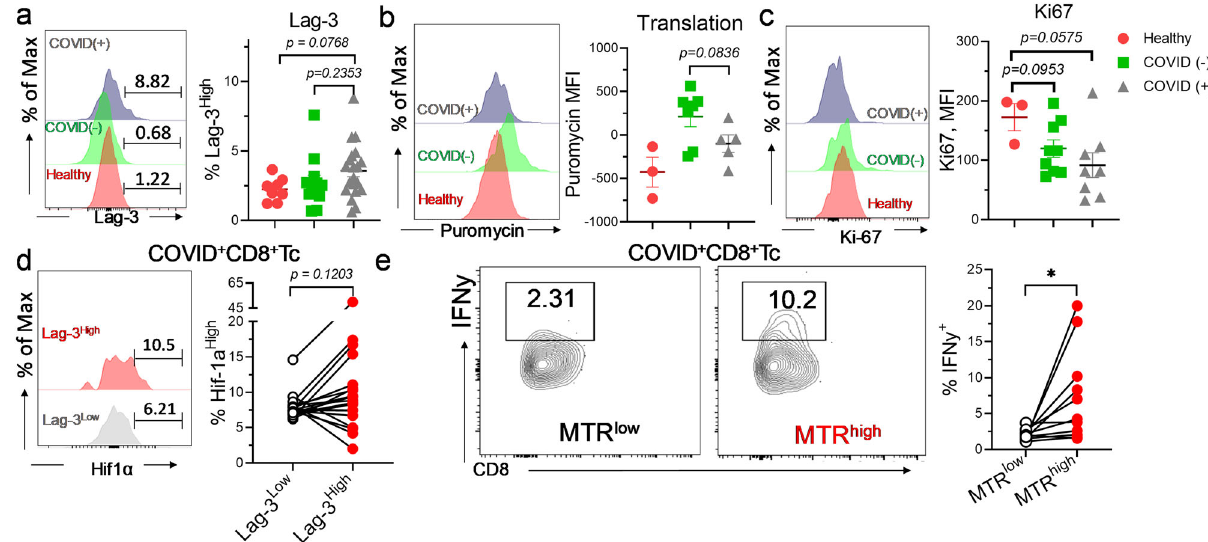
Fig. 3 CD8 + Tc are functionally exhausted in severe COVID-19 patients. Freshly isolated PBMCs were evaluated for metabolic properties by fl ow cytometry. a – c Representative histogram and summary graph demonstrating the abundance of lag-3 + CD8 + Tc ( n = 8 HD, 12 C − , 20 C + ) ( a ), cellular translational level via Puromycin ( n = 3 HD, 7 C − , 5 C + ) ( b ), and Ki-67 expression ( n = 3 HD, 9 C − , 8 C + ) ( c ) in CD8 + Tc from healthy, COVID( − ), and COVID( + ) patients. d Representative histogram and paired graph abundance of HIF-1 α High cells in lag-3 low and lag-3 high CD8 + Tc from COVID( + ) patients ( n = 18). e Representative contour plot and summary paired graph demonstrating IFNy + cells in MTR low and MTR high CD8 + Tc from COVID( + ) patients ( n = 11). b , d One sample was excluded due to critically low CD8 + Tc count; in c , three samples were excluded due to critically low CD8 + Tc count. Two- tailed student ’ s t test was used. * p < 0.05, ** p < 0.01, and *** p <